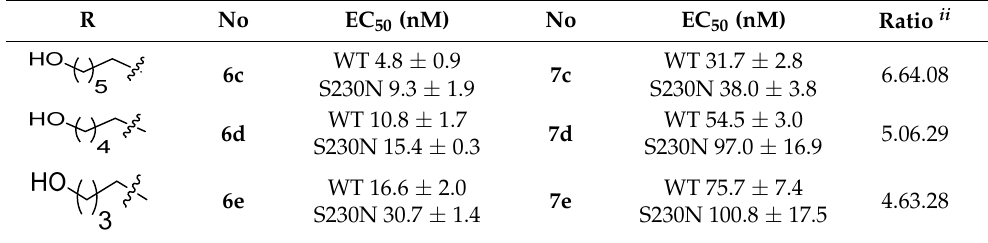
Table 2. Antiviral Potencies in Cells Infected with HIV-1 Vectors Bearing the S230N IN Mutant i . . R